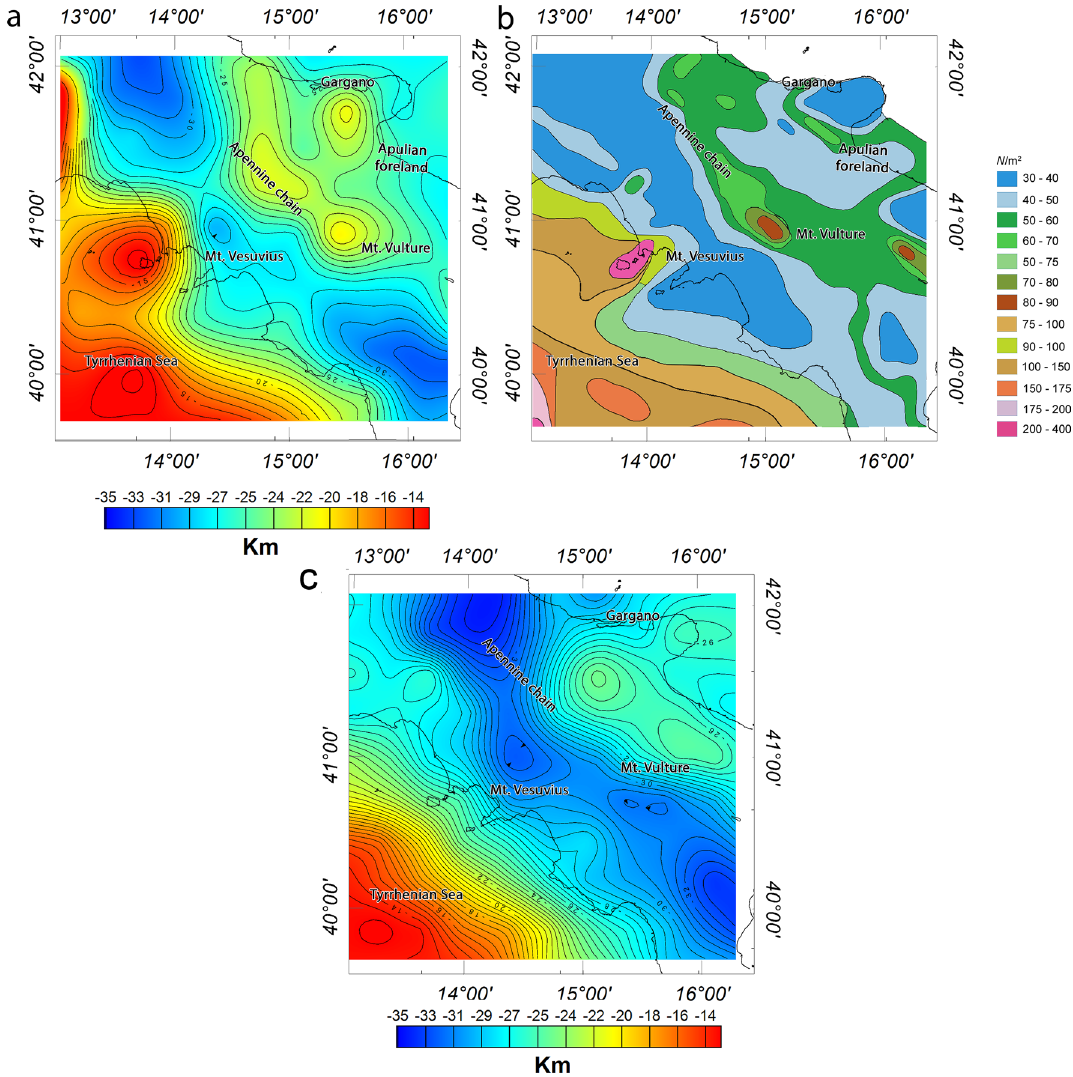
Figure 7. Depth to the bottom of magnetic sources ( a ), heat flow map ( b ) and Moho depth estimated from gravity data ( c ). The maps were generated using the Oasis Montaj Geosoft software (v.9.9.1.34 https:// www. seequ ent. com/ produ cts- solut ions/ geoso ft- oasis-